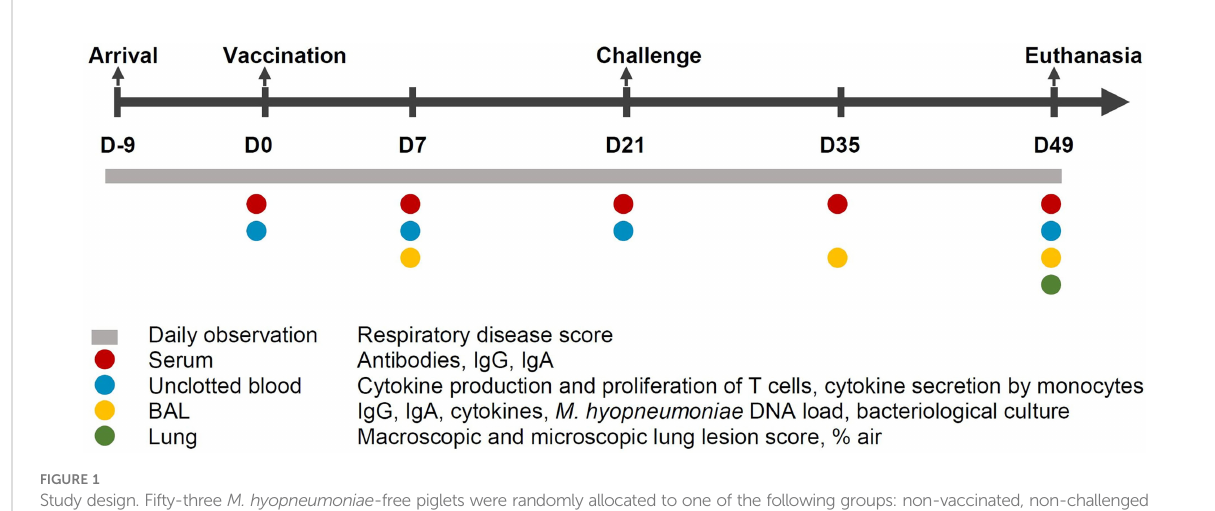
FIGURE 1 Study design. Fifty-three M. hyopneumoniae -free piglets were randomly allocated to one of the following groups: non-vaccinated, non-challenged sentinel group (S; n = 5); non-vaccinated, challenged control group (C; n = 12); vaccinated with commercial vaccine 1 group (V1; n = 12); vaccinated with the adjuvant of commercial vaccine 1 group (A; n = 12); vaccinated with commercial vaccine 2 group (V2; n = 12). BAL, broncho-alveolar lavage; D,